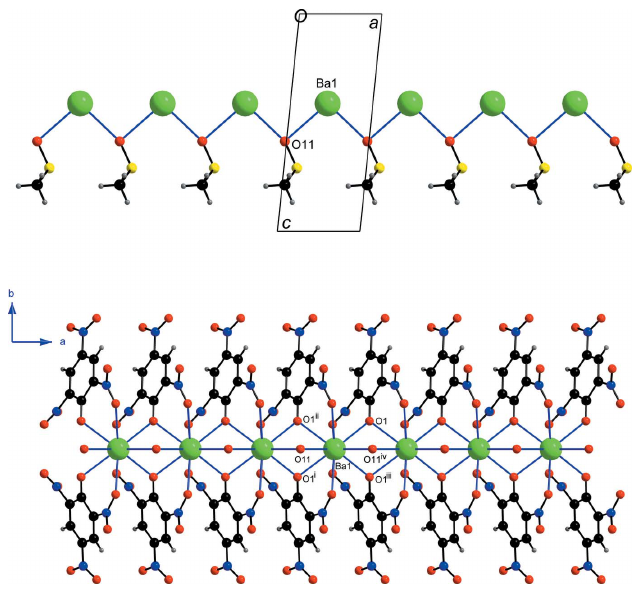
Figure 3 (Top) Ba II cations bridged by O11 of DMSO, which results in the formation of chains extending along the a -axis direction. For clarity, the disordered S atom and the methyl group of the DMSO ligands as well as the picrate ligands are not displayed; (bottom) the chain showing the (cid:2) 2 -monoatomic bridging binding of the picrate and DMSO ligands. For clarity, only the bridging O11 atom of the DMSO ligands are shown. Each Ba II atom in the chain is bonded to ten O atoms (see Fig. 2).